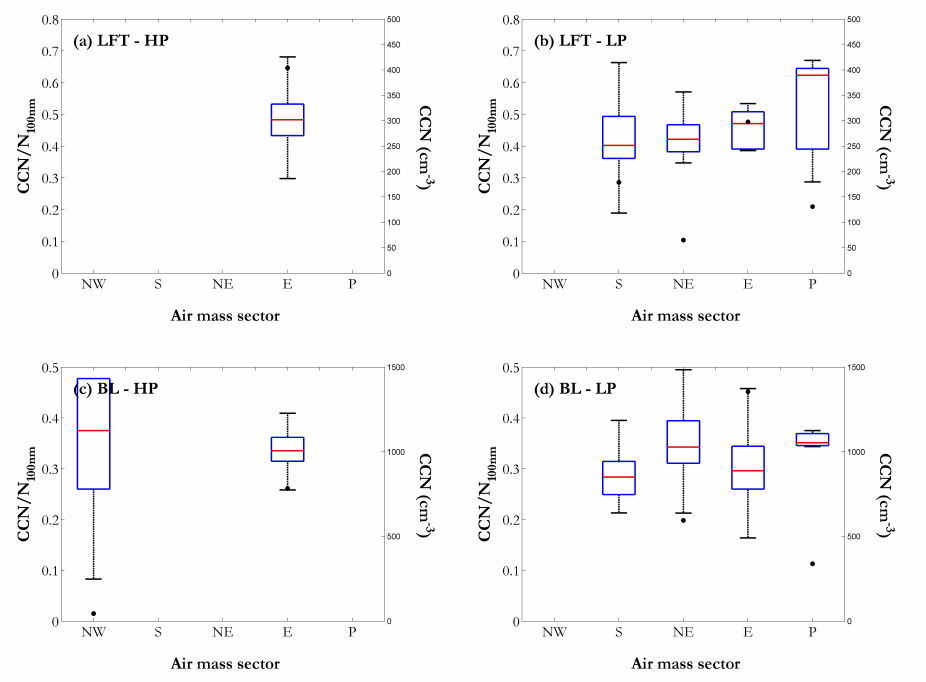
Fig. 7. CCN/ N 100 ratios as a function of the air mass origin (NW: north-west Europe; S: south Europe; NE: north Europe; E: east Europe; P: Polar) in the lower free troposphere during anticyclonic (HP, a ) and cyclonic (LP, b ) conditions as well as in the boundary layer during anticyclonic (HP, c ) and cyclonic (LP, d ) conditions. Black points represent the median CCN concentration (right scale). Lower and upper limits of the box correspond to 25% and 75% percentiles, bottom and top whiskers the 5% and 95%. Middle red bars indicate the median CCN/N100